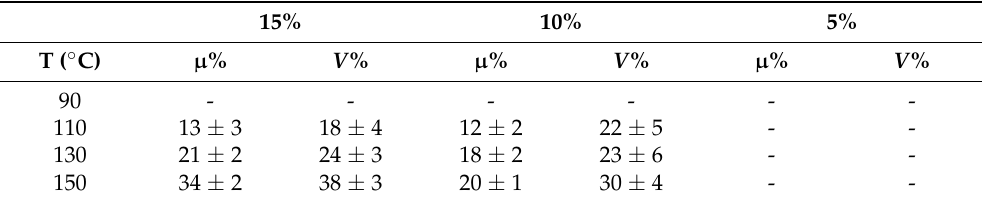
Table 2. Results of the self-healing efficiencies of samples using the custom crack machine with different activation temperatures and PCL concentrations.